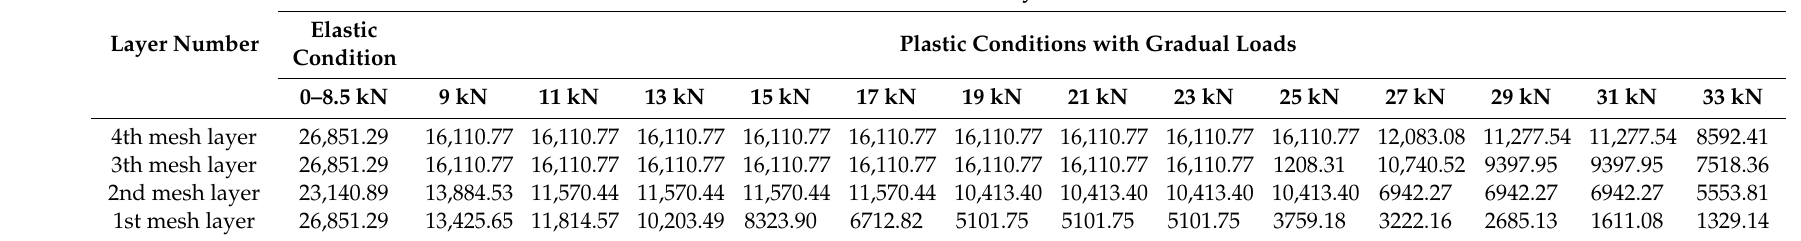
Table 7. The modulus of elasticity for each layer of the BRC beam in the non-linear phase.